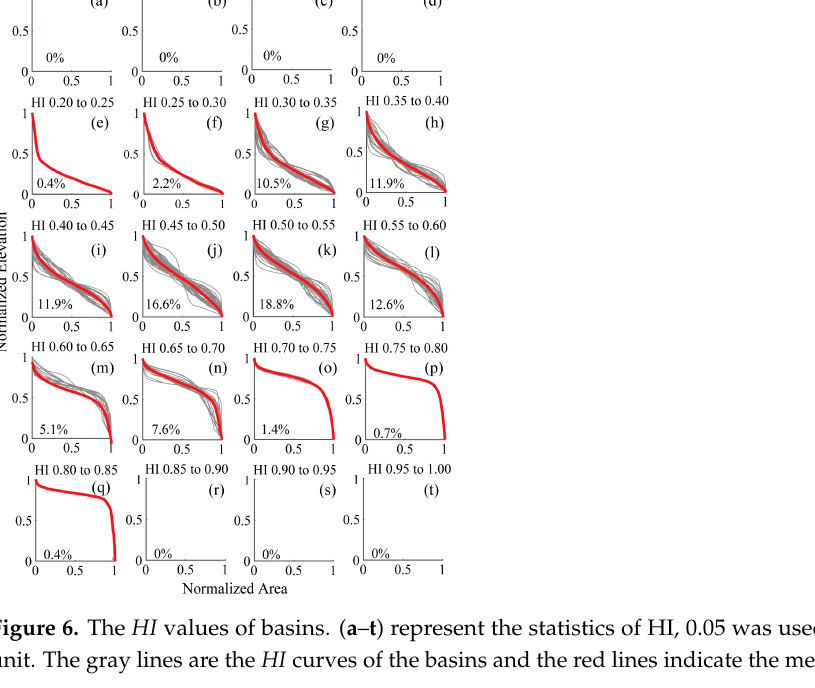
Figure 7. The HI values of the Yabrai Shan basins based on digital elevation model data.